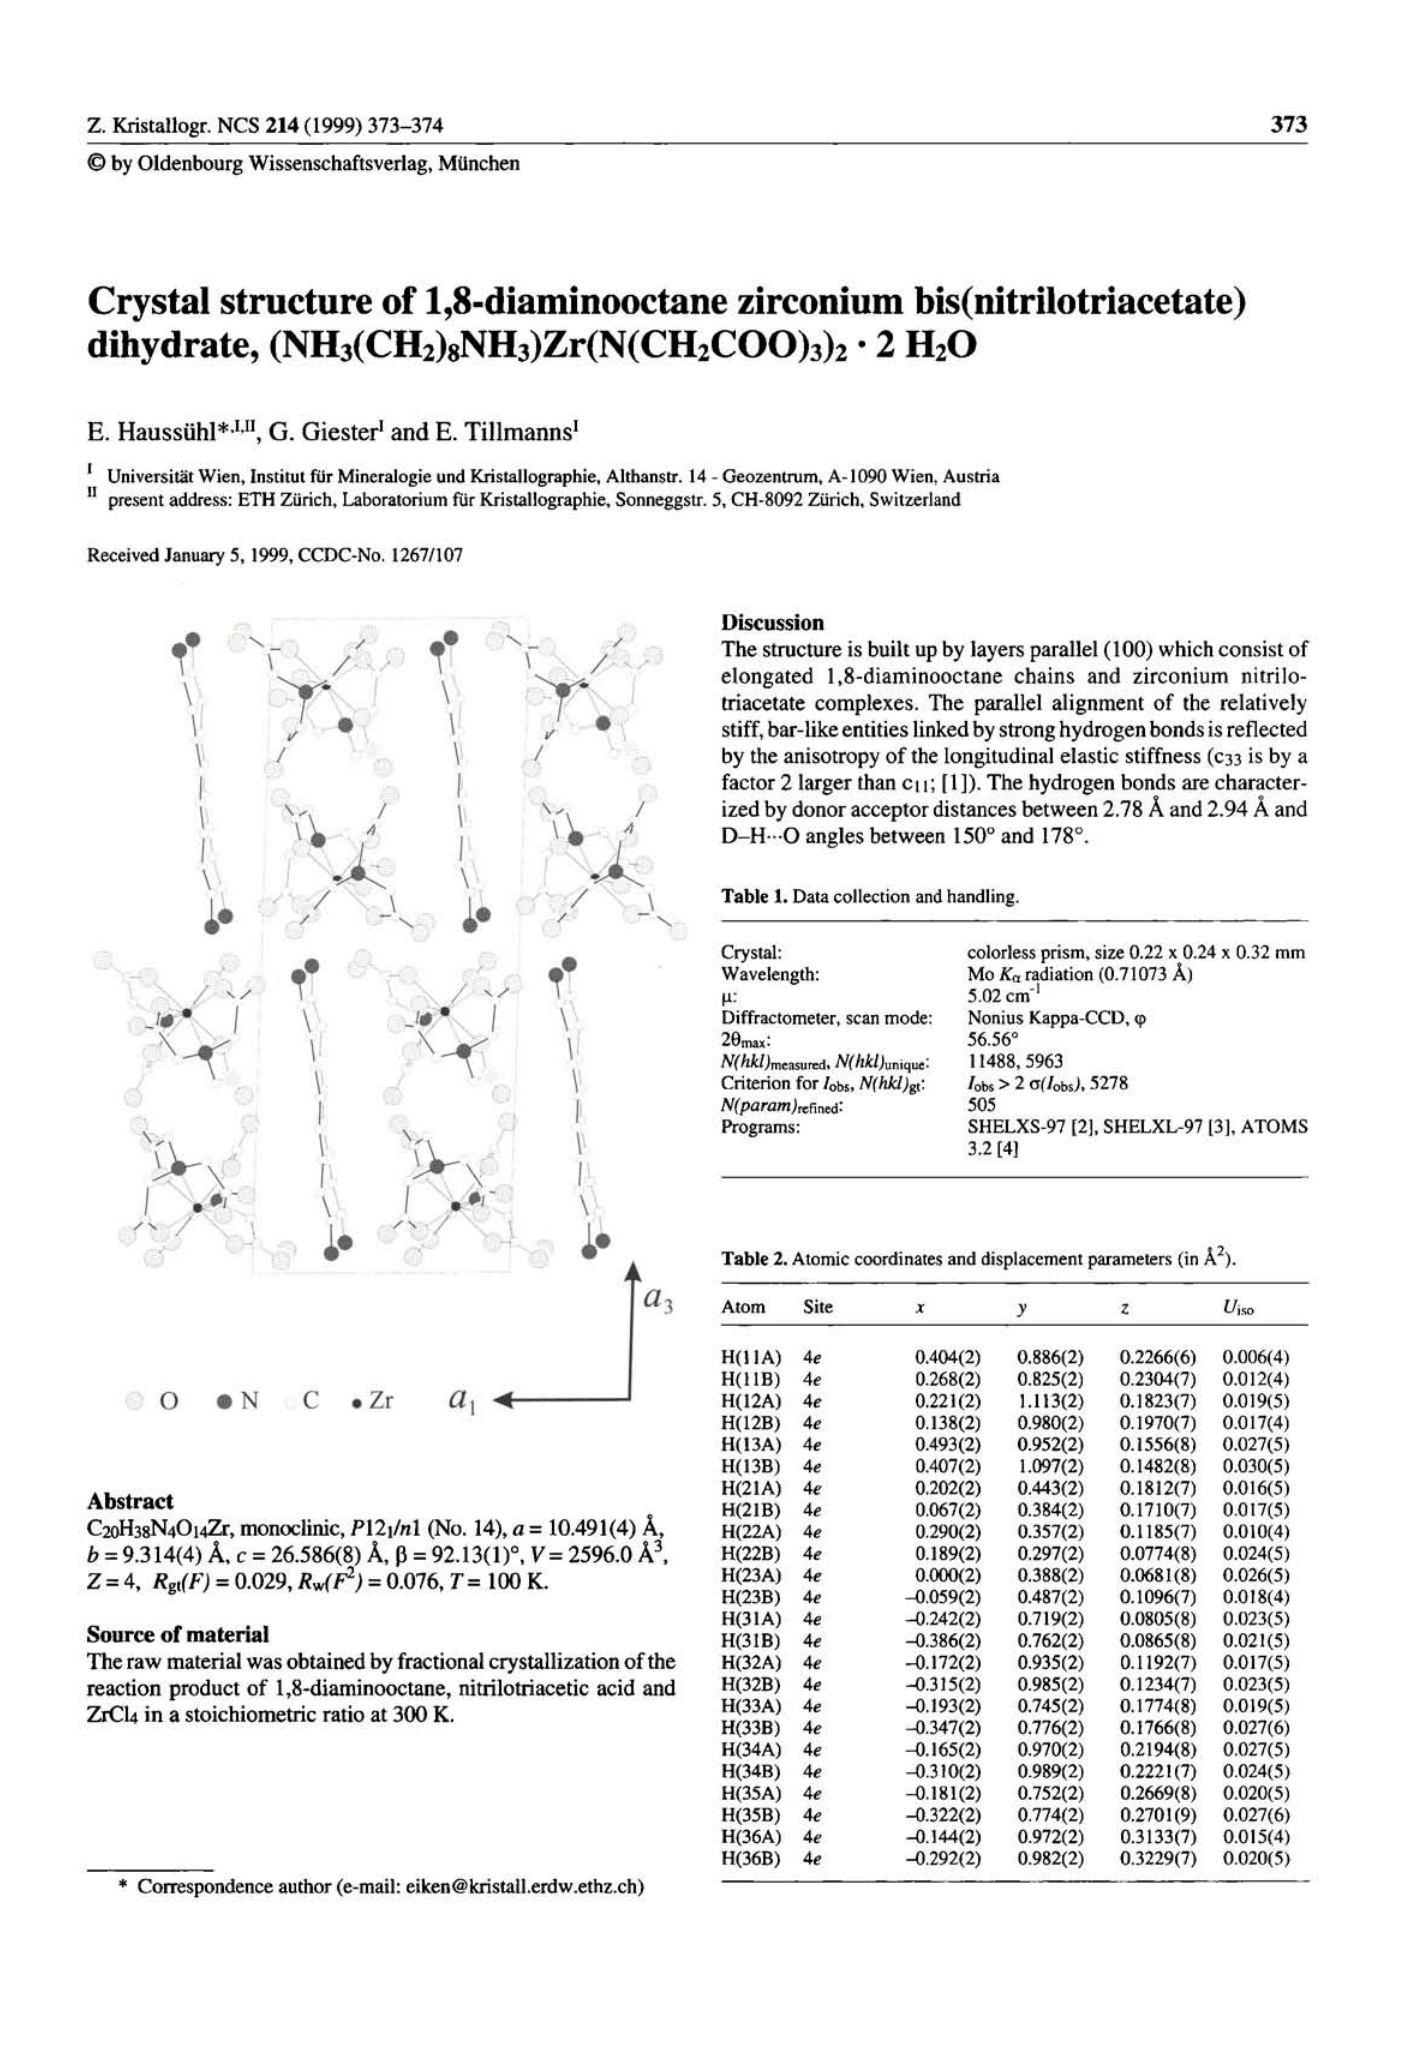
Table 2. Atomic coordinates and displacement parameters (in A 2